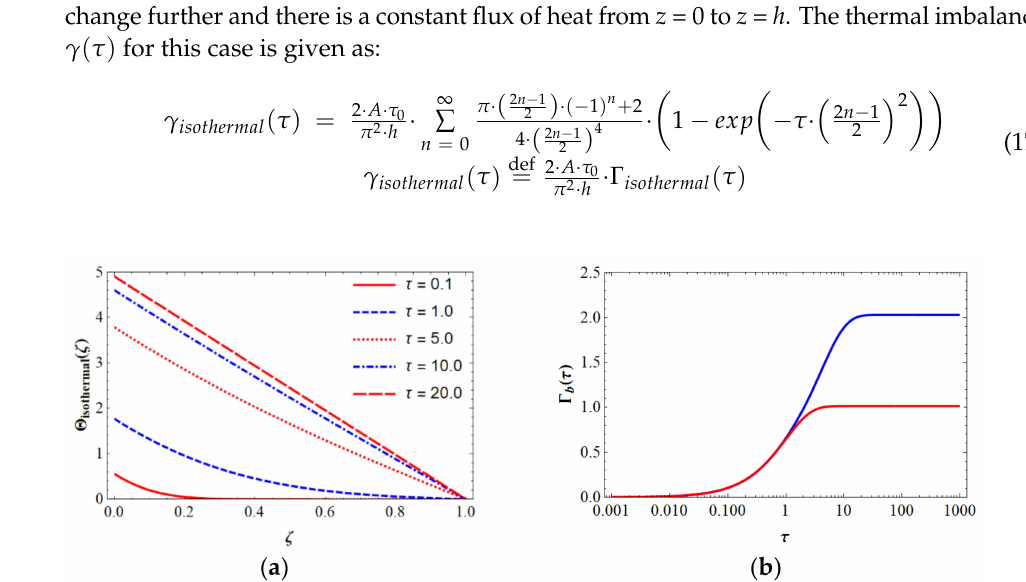
Figure 10. ( a ) The temperature profile Θ isothermal ( ζ ; τ ) at values of τ = 0.1, 1, 5, 10, and 20. ( b ) The transient behavior of Γ isothermal ( τ ) as blue line. For comparison Γ isolated ( τ ) is given as a red line in this